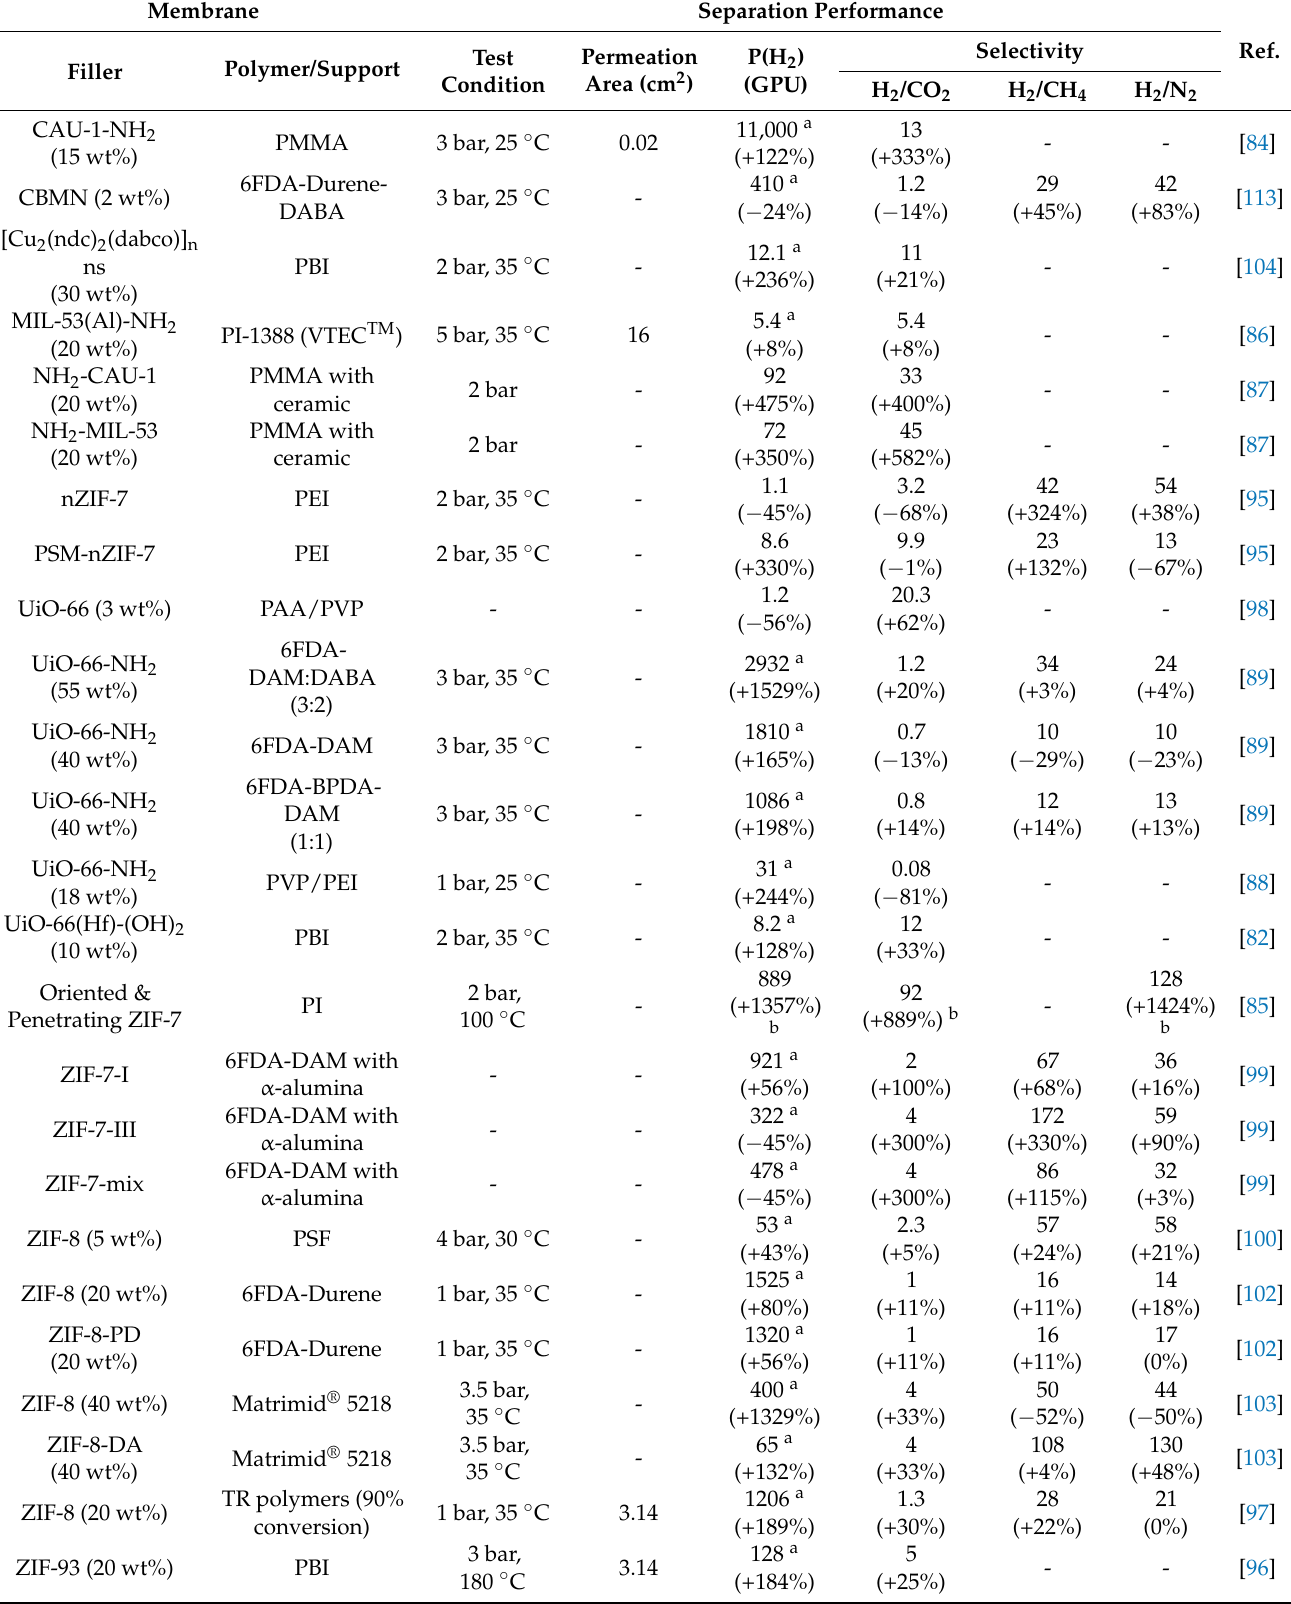
Table 3. Summary of representative performances for MOF-based membranes in H 2 -based separation. Membrane Separation Performance